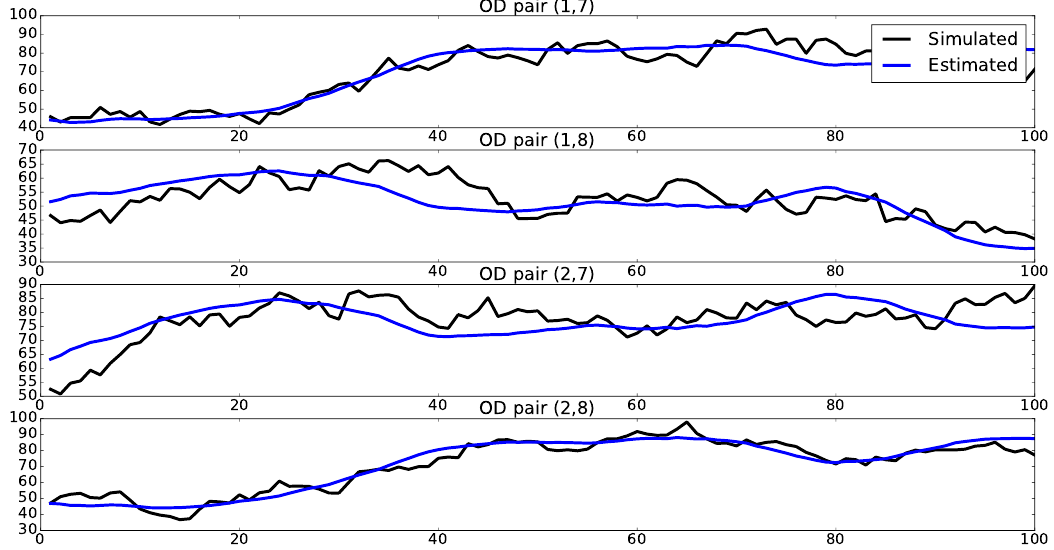
Figure 6. Simulated and estimated mean OD flows for δ = 0.9. Horizontal axes show time periods, while vertical axes show magnitude of OD flows.